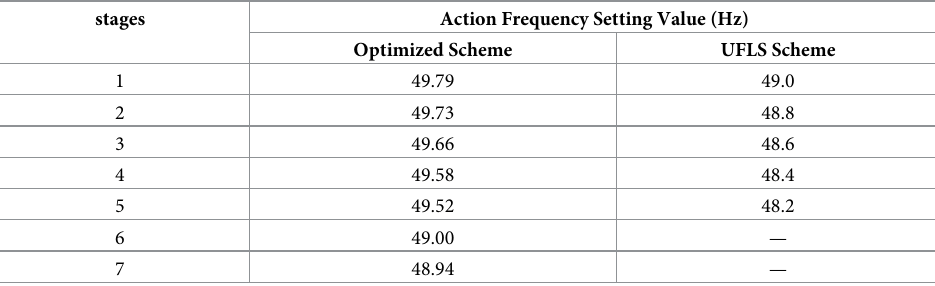
Table 8. Two comparison schemes (Case 1).